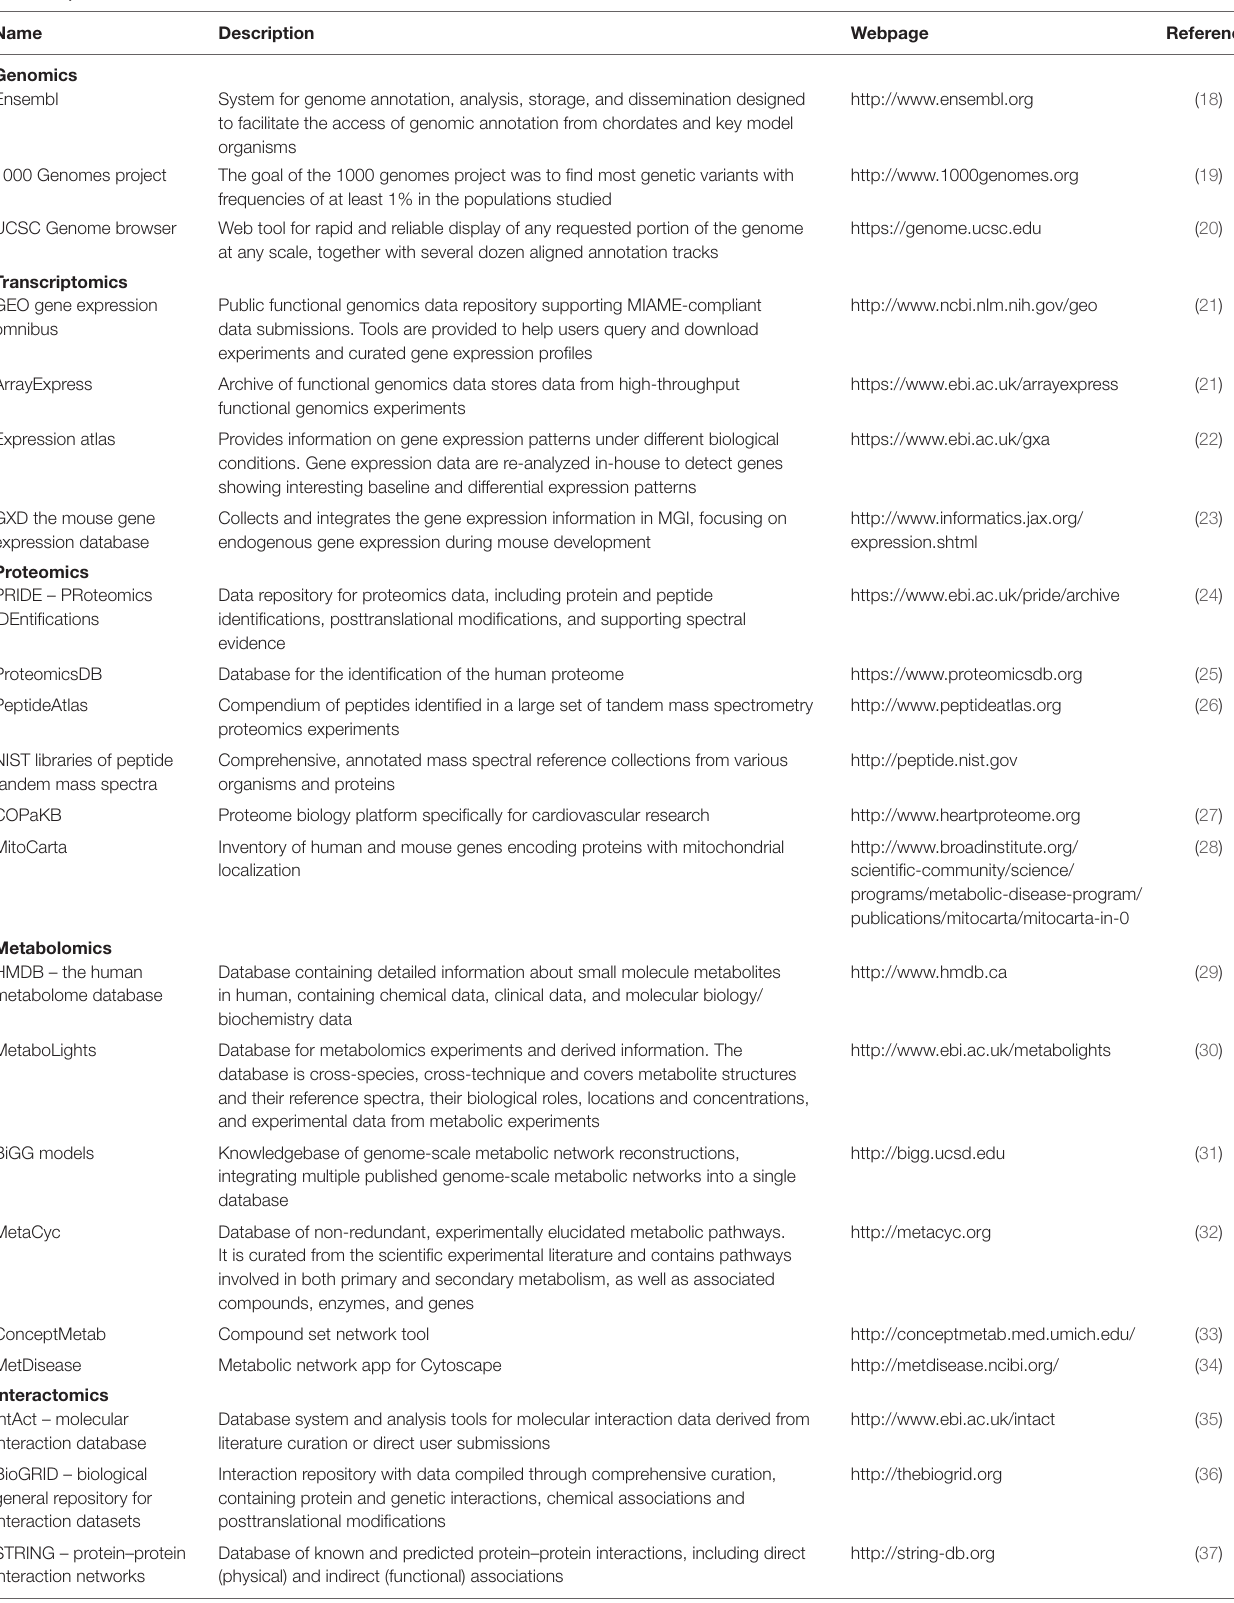
TABLe 1 | Tools and resources for omics